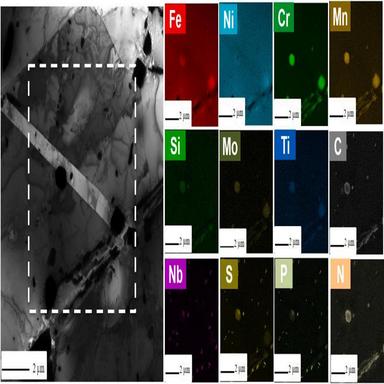
BF TEM and Chemical Maps of Alloy 709 after 900 ◦C and 50 MPa Creep Test showing Twin Boundary and Precipitates.